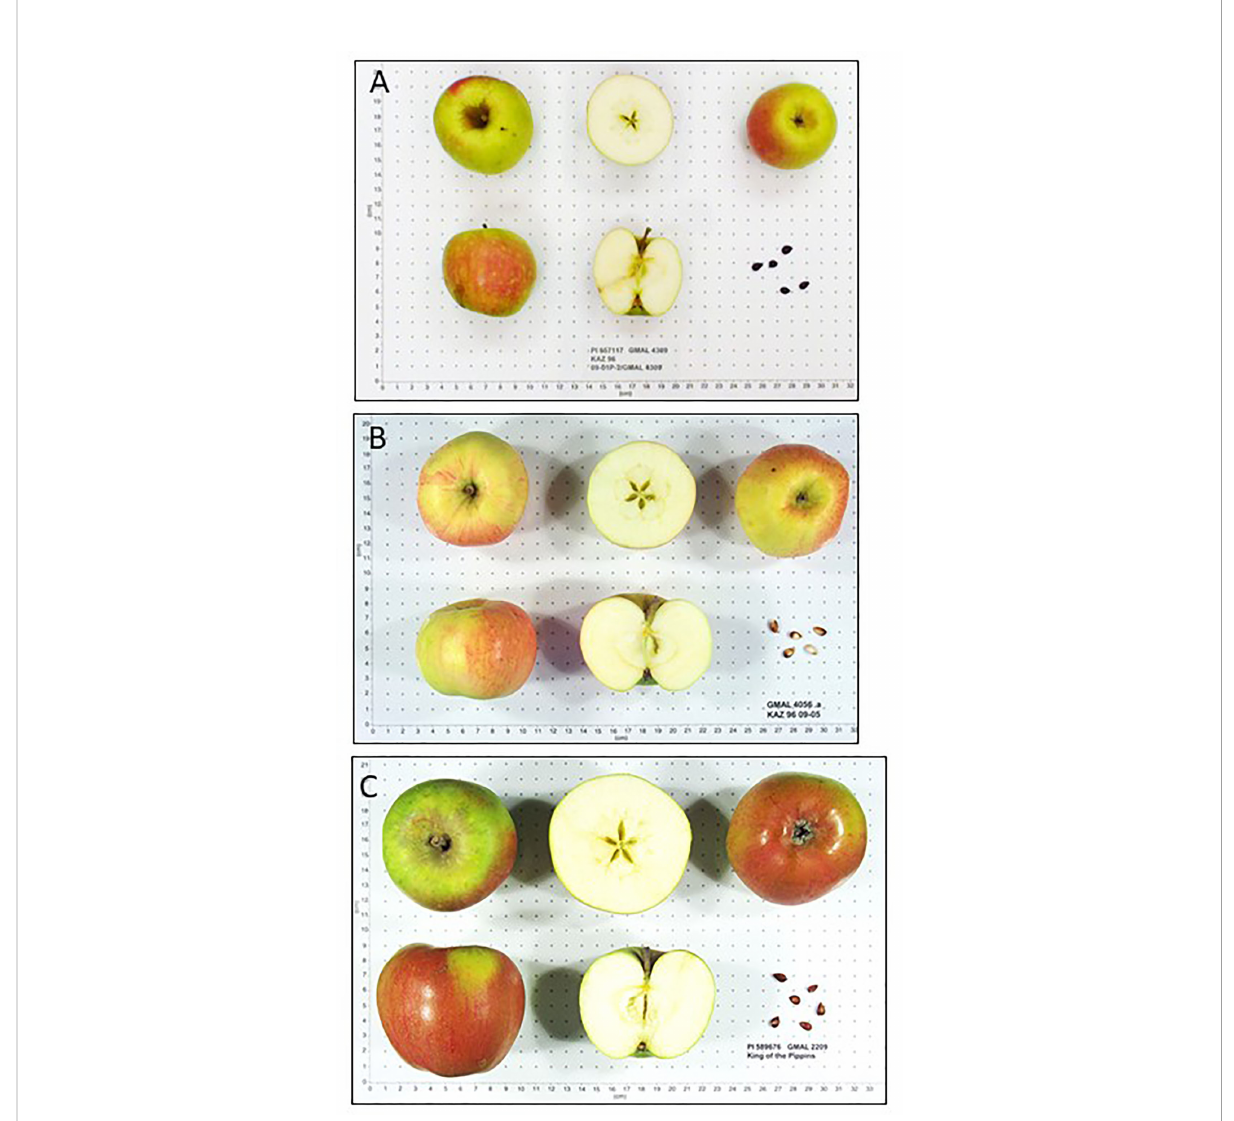
FIGURE 3 Malus fruit images from the USDA-NPGS apple collection (A) PI 657117 collected from Kazakhstan Site 12, determined to be pure M. sieversii ; (B) PI 682787 collected from Kazakhstan Site 12, determined to be a hybrid between M. sieversii and M. domestica ‘ King of the Pippins ’ ; (C) Accession PI 589676, M. domestica ‘ King of the Pippins ’